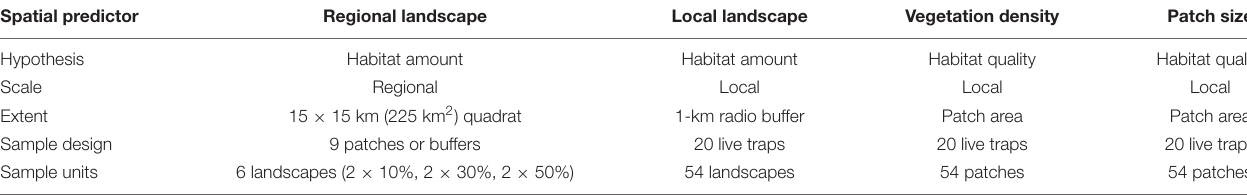
TABLE 1 | The three level spatial extents measured in this study, which were used as predictors for small-mammal composition and richness.